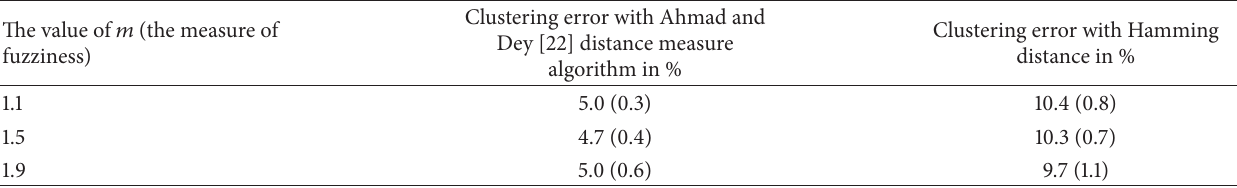
Table 2: Average clustering results with standard deviation, in brackets, for Wisconsin breast cancer dataset. For all values of 𝑚 , Ahmad and Dey [22] distance measure performed better.